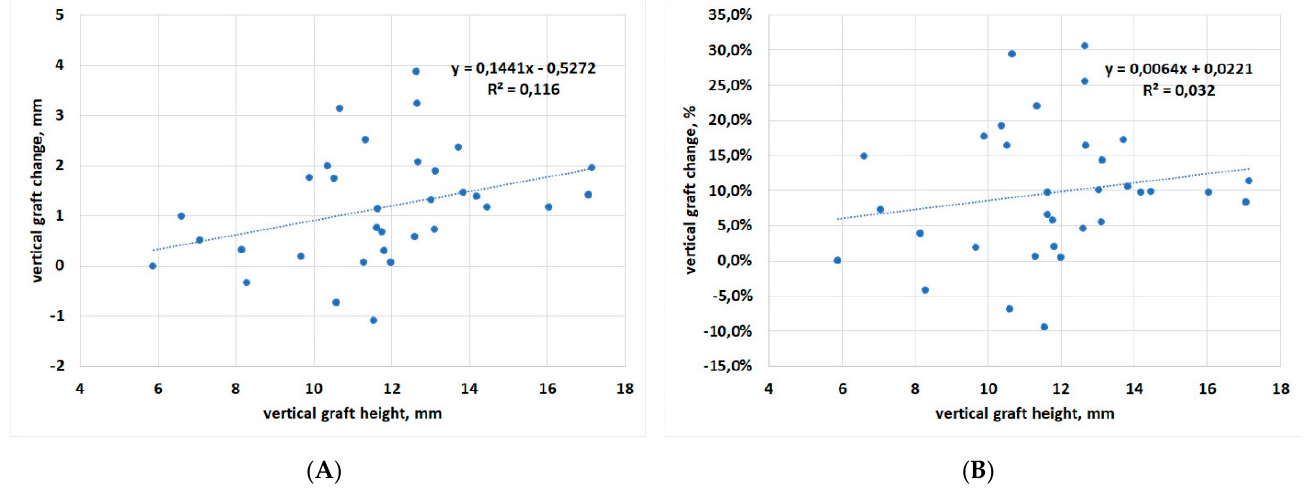
Figure 6. Regression analysis for vertical dimension change with respect to baseline. ( A ) data in mm; ( B ) data in percentage.